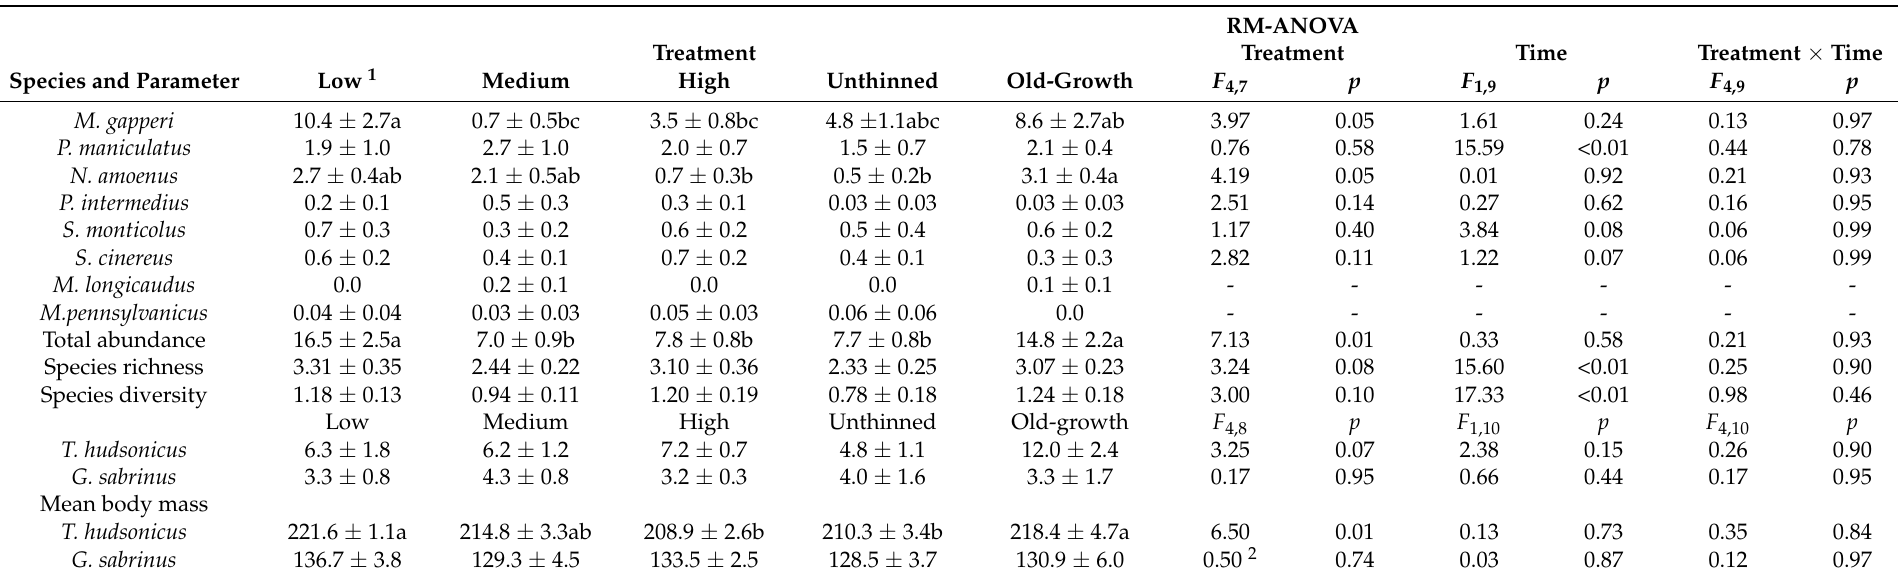
Table 3. Overall mean ( n = 6; 3 replicate sites × 2 years) ± SE abundance (density index) of each species, total abundance, species richness, and species diversity of the forest-floor small mammal community (2013–2014), and abundance and body mass of tree squirrels (2014–2015) in the five treatments, and results of RM-ANOVA. Within a row mean values with different letters (a, b, or c) are significantly different by Duncan’s multiple range test. Significant values in bold